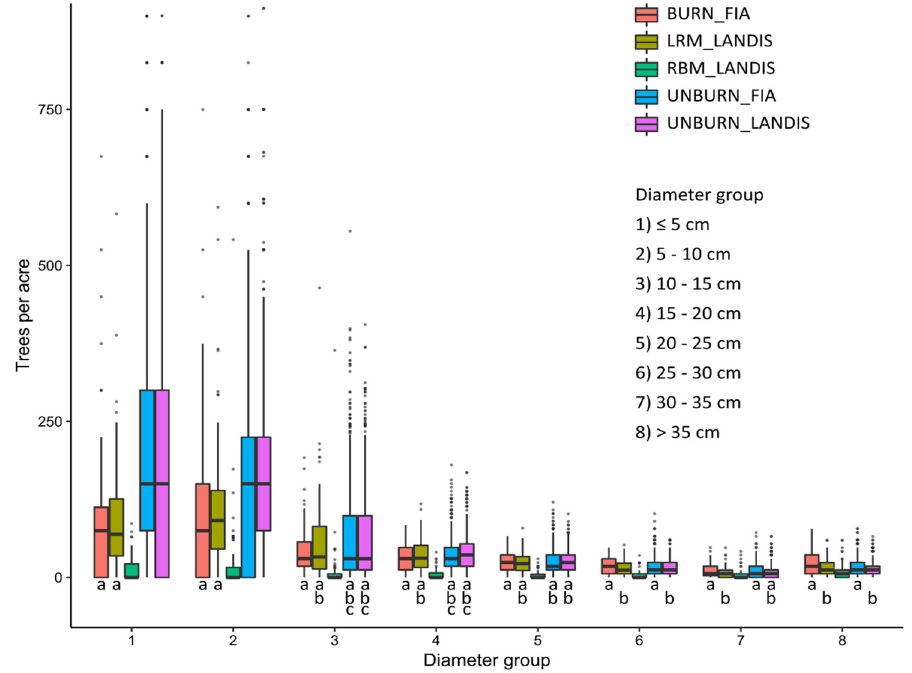
Figure 2. Boxplot showing stem densities within eight diameter groups from the Ozark Highlands study area. Estimates from U.S. Forest Service Forest Inventory and Analysis plots that experienced fire within the previous five years (BURN_FIA, n = 67) are compared with plots with no recorded fire (UNBURN_FIA, n = 1972), predictions made by LANDIS PRO using a logistic regression probability of fire mortality model (LRM_LANDIS), predictions made by LANDIS PRO using a rule-based fire mortality model (RBM_LANDIS), and predictions from LANDIS PRO with no fire (UNBURN_LANDIS). Letters below bars denote which density estimates did not differ significantly at an α of 0.05 using a pairwise comparison using the Wilcoxon rank sum test within each diameter group.